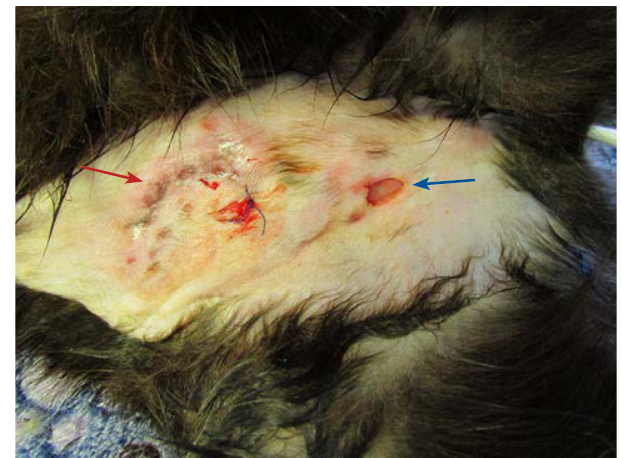
Figure 1: Inguinal biopsy site (head is to the left) Red arrow: ‘pepper pot’ lesions thought to be suggestive of infection with NTM in cats (Greene et al. 2012). Blue arrow: full-thickness defect, not a biopsy